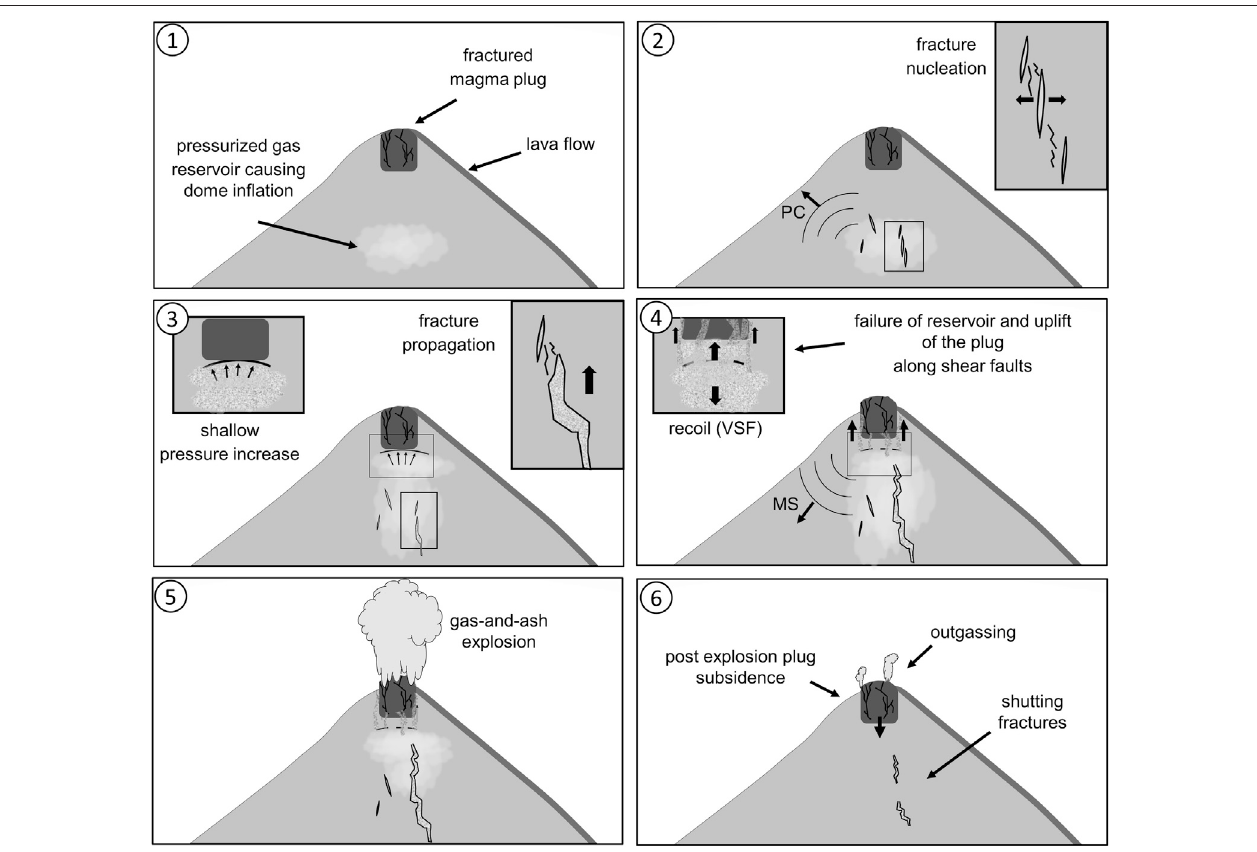
FIGURE 11 | Proposed source mechanism of weak-to-moderate explosions at Santiaguito: 1) gas accumulates at a depth of ∼ 600 m and causes the dome to in fl ate (positive tilt). 2) The increased gas pressure causes fracture nucleation and the seismicity related to the opening of tensile fractures is attributed to the PC signal describedinthisstudy.3)Asfracturespropagateupwardsandunzip,gasrapidlyrisesincreasingthepressurebelowtheshallowmagmaplug.4)Withthepropagationof tensile fractures into the shallow plug, they intersectwith existing fractures and causefault-slip controlled uplift ofthe plug. The recoil of the rapid upward motion of massmaycauseadownwarddirectedVSF,whichisconsistentwithour fi ndingsfortheMS.5)Gasandashisejectedatthecratersurface.6)Intheposteruptivephase the plug subsides and the volcano edi fi ce de fl ates (negative tilt). Shutting fractures in the volcano interior decreases the permeability for gas rise and the activity at the crater is characterized by weak outgassing.